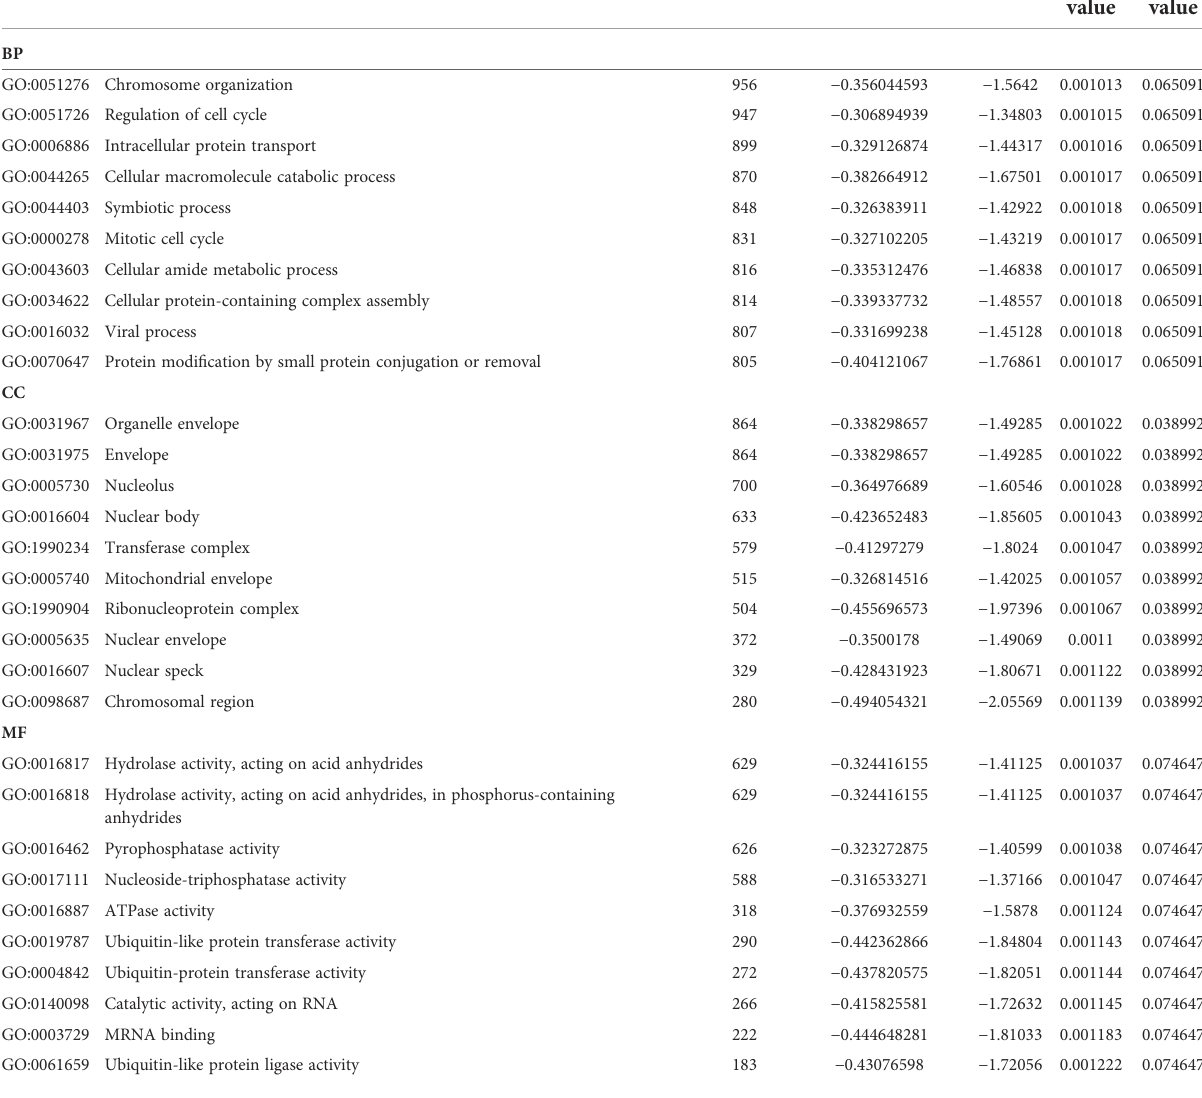
TABLE 1 Top 10 biological process (BP), cellular component (CC), and molecular function (MF) terms included in GO terms in OP (|NES| > 1, p -w fi 2value < 0.05, q -value < 0.25).